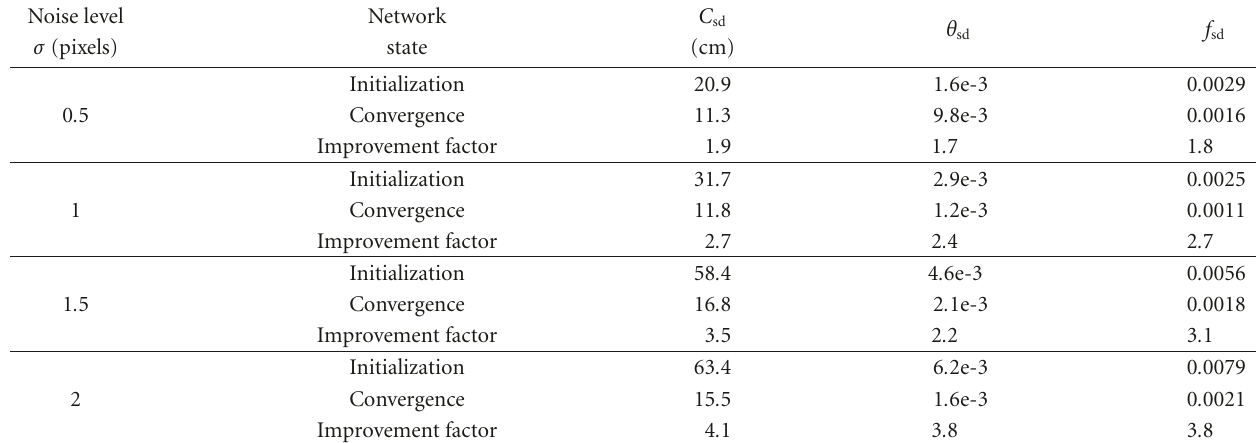
Table 2: Summary of the calibration consistency. C sd is the average standard deviation of error in camera centers in cm (relative to a scene width of 220 m). θ sd is the average standard deviation of orientation error between rotation matrices given by (15). f sd is the average standard deviation of focal length